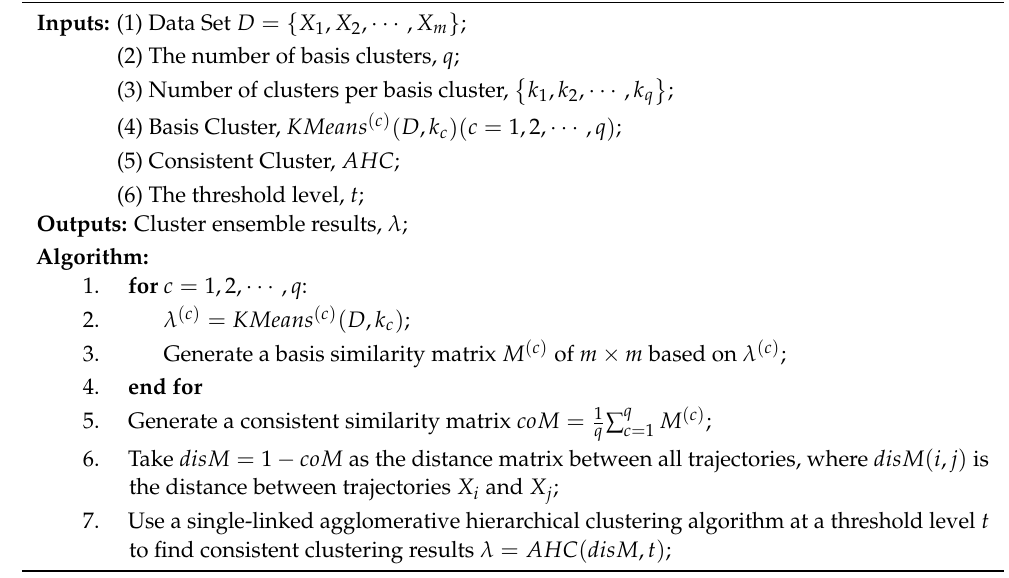
Algorithm 1. Clustering ensemble algorithm based on